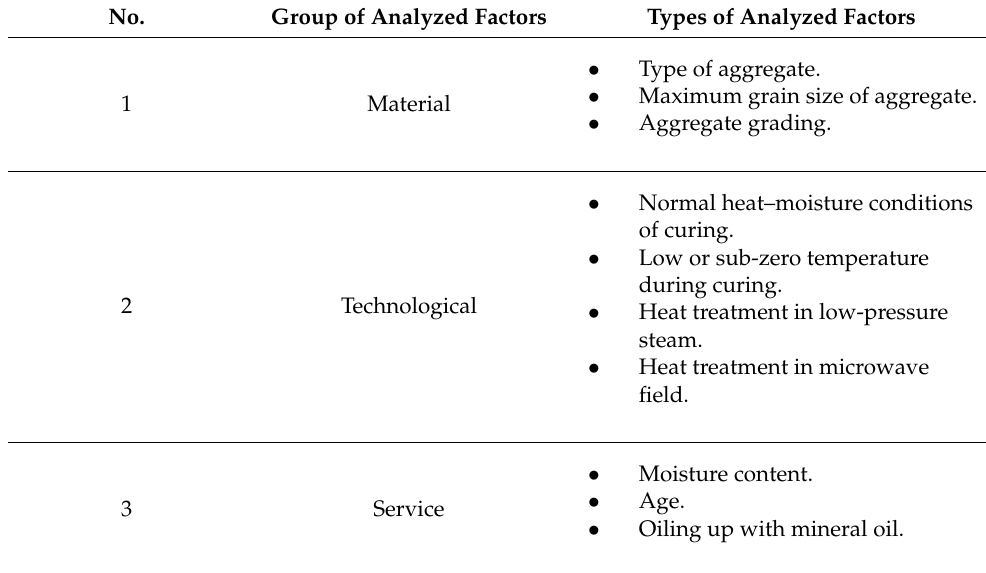
Table 1. The main material, technological, and operational factors influencing the levels of critical stresses and the process of destruction of ordinary concrete (according to